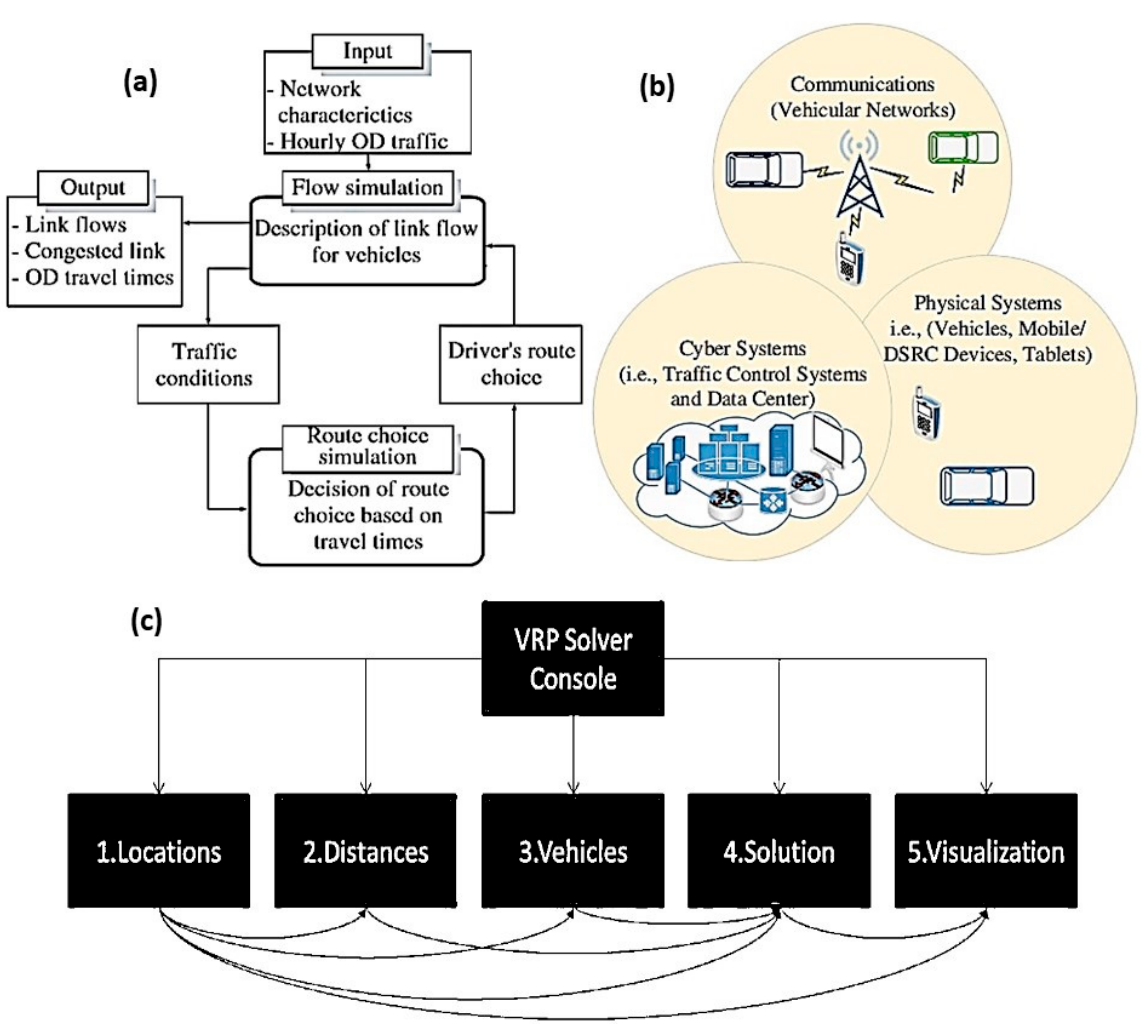
Figure 2. ( a ) Structure of the block density model [27] ( b ) Vehicular Cyber Physical System (VCPS) [37] ( c ) Spreadsheet structure of VRP Spreadsheet Solver [38].